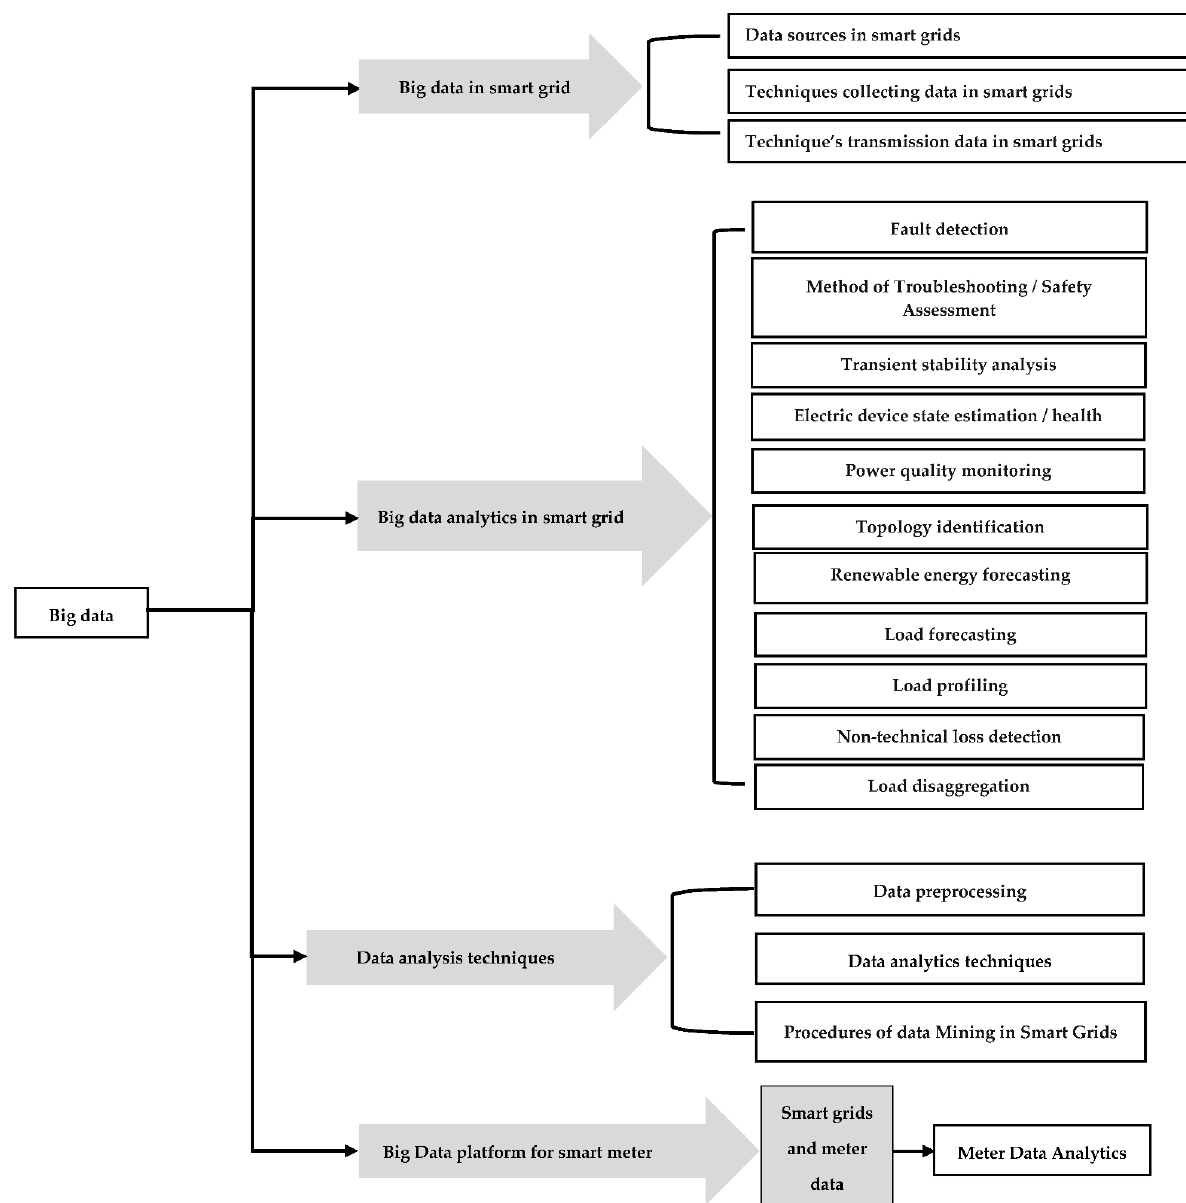
Figure 8. Big data mechanisms.